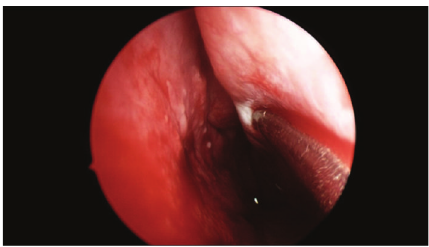
Figure3:Coalescingpustulareruptionsinvolvingthenasalmucosa.